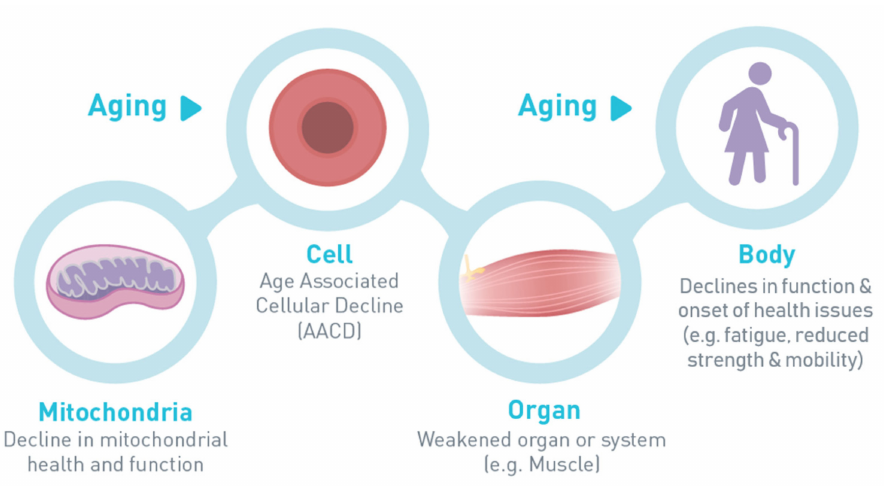
Figure 1. Mitochondrial origin of age-related